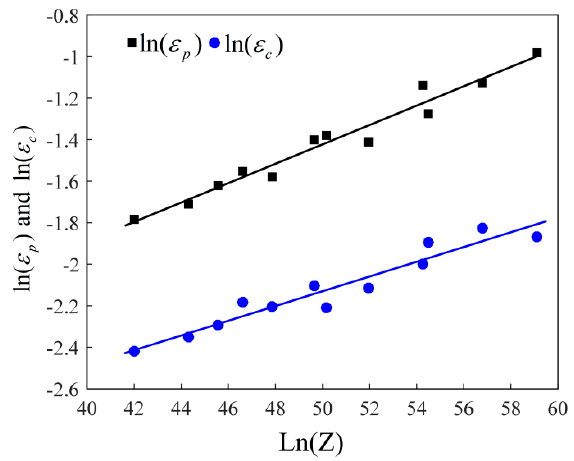
Figure 6. Relationships between ln ( Z ) − ln ( ε p ) and ln ( Z ) − ln ( ε c ) .